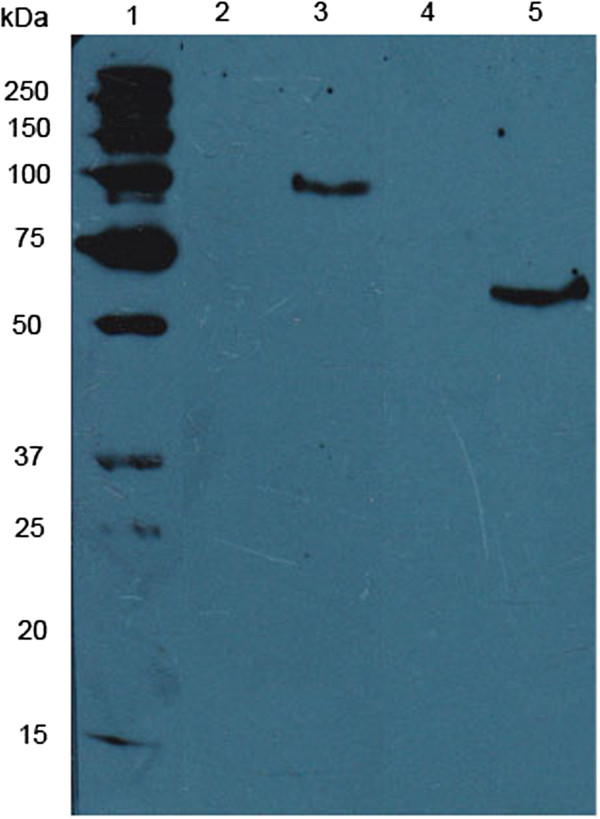
Western blot of rPPDK and rGal/GalNAc lectin using anti-His-HRP (Novagen, Gemany). Lane 1: Precision Plus Protein™ Unstained Standard Marker (Bio-Rad, USA); Lanes 2 and 4: E.coli whole cells transformed with pET28a(+) vector as a control; Lane 3: E.coli whole cells expressed rPPDK; Lane 5: E.coli whole cells expressed rGal/GalNAc lectin.